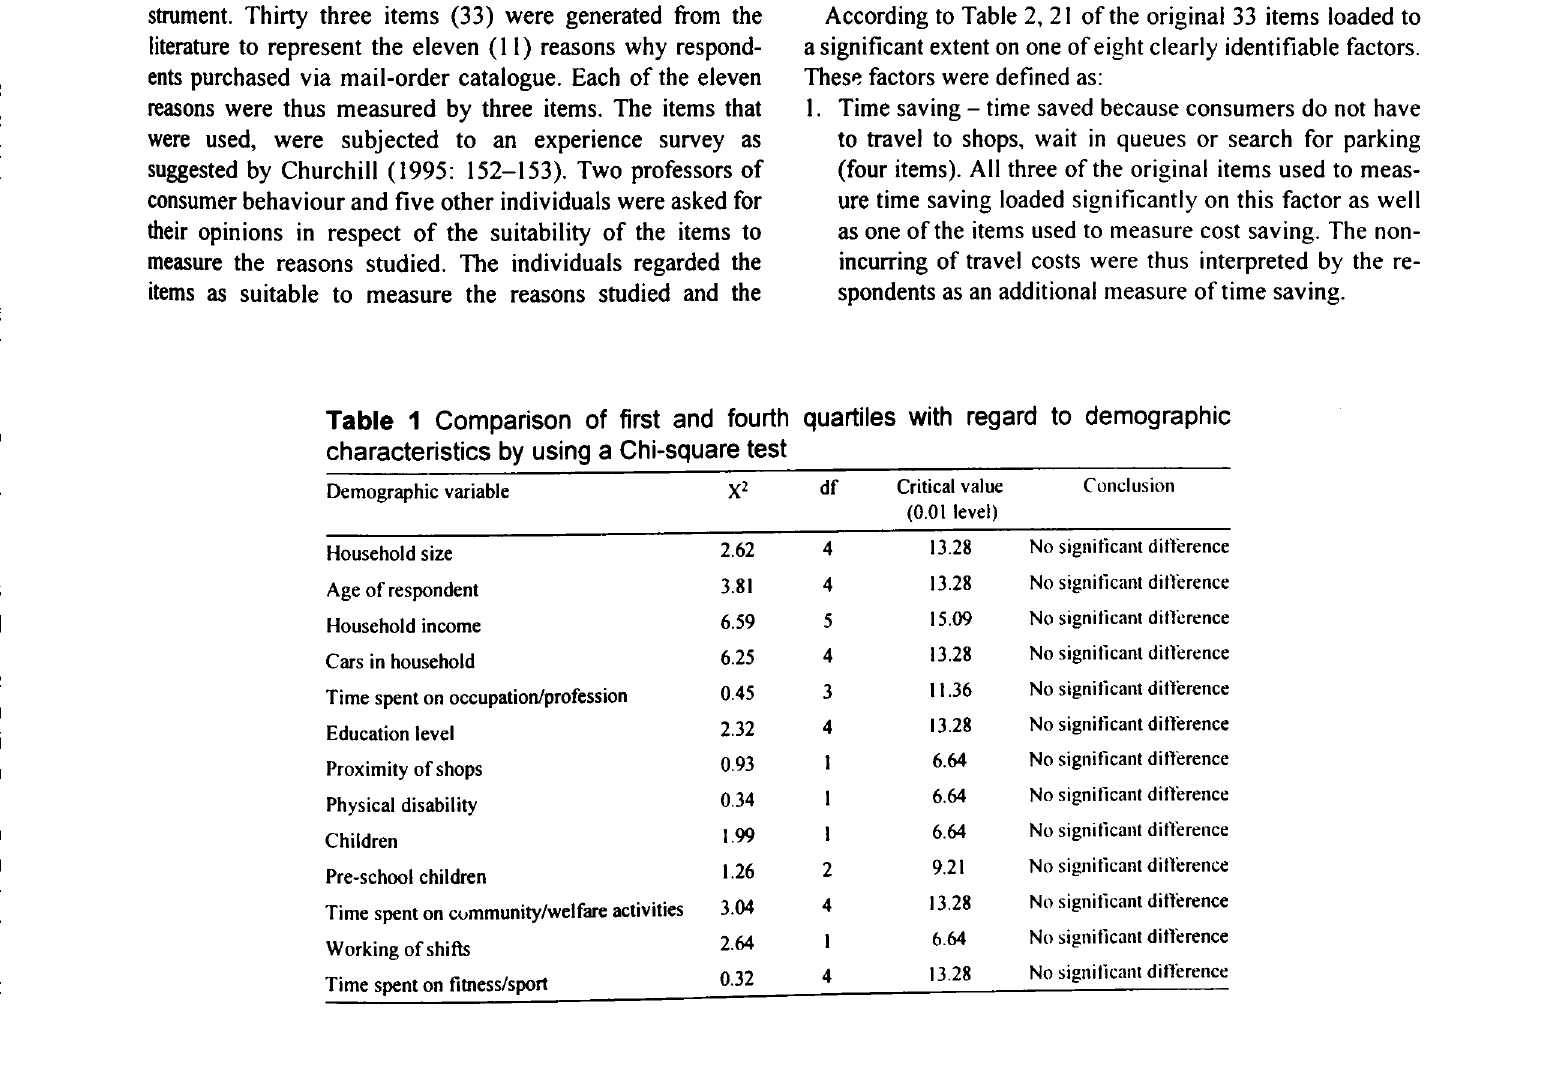
Table 1 Comparison of first and fourth quartiles with regard to demographic characteristics by using a Chi-square